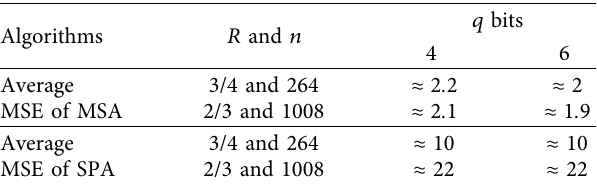
Table 1: MSE between the nonquantized values and the quantized values for check nodes processing.